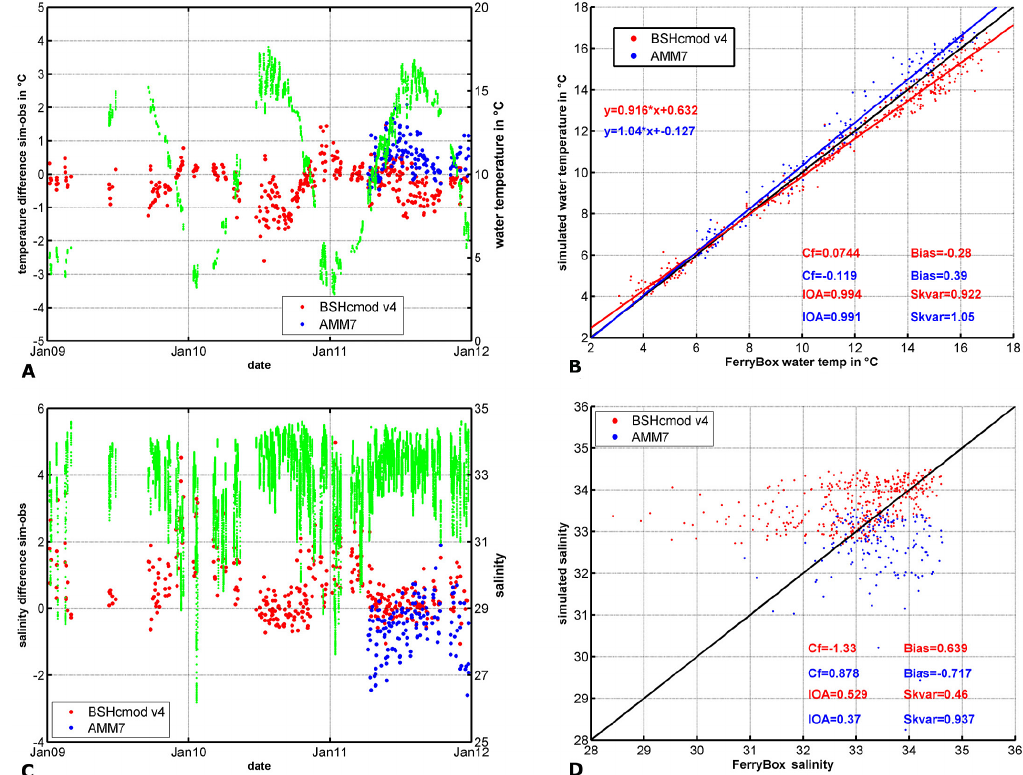
Figure 9. Upper panels: time series of temperature differences and absolute FerryBox values (in green) (a) and scatterplot of temperatures (b) of FerryBox measurements of TorDania and Lysbris and model results at the eastern coast of England (p1). Lower panels: time series of salinity difference and absolute FerryBox values (in green) (c) and scatterplot of salinity (d) of FerryBox measurements of TorDania and Lysbris and model results at the eastern coast of England